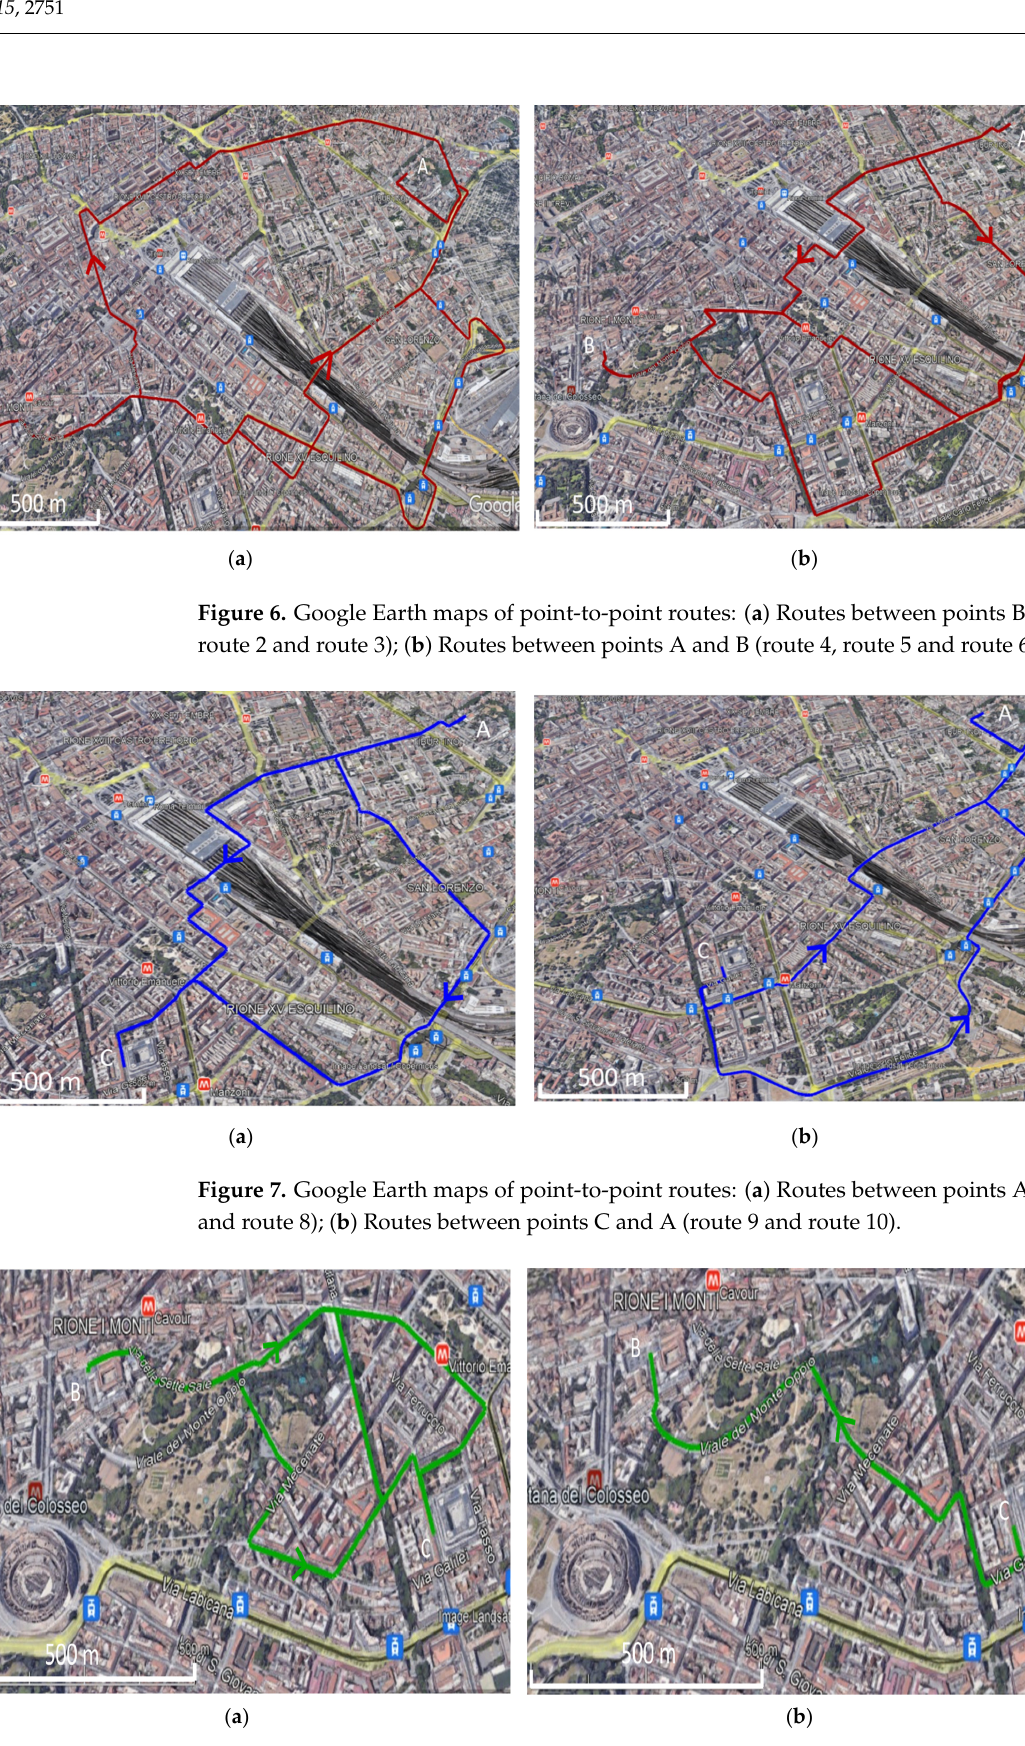
Figure 8. Google Earth maps of point-to-point routes: ( a ) Routes between points B and C (route 11, route 12 and route 13); ( b ) Routes between points C and B (route 14). The main data of the plano-altimetric profiles, i.e., length, maximum and minimum slope, average bending radius, are summarized in Table 2. The lengths are in the range between 1.4 km and 5.7 km, with maximum and minimum slope ranging from 3.8% to 7.6% and from − 8.1% to − 3.5%, respectively. The average bending radius varies between 30 m and 276 m. Table 2. Main data of the plano-altimetric profiles. Route ID